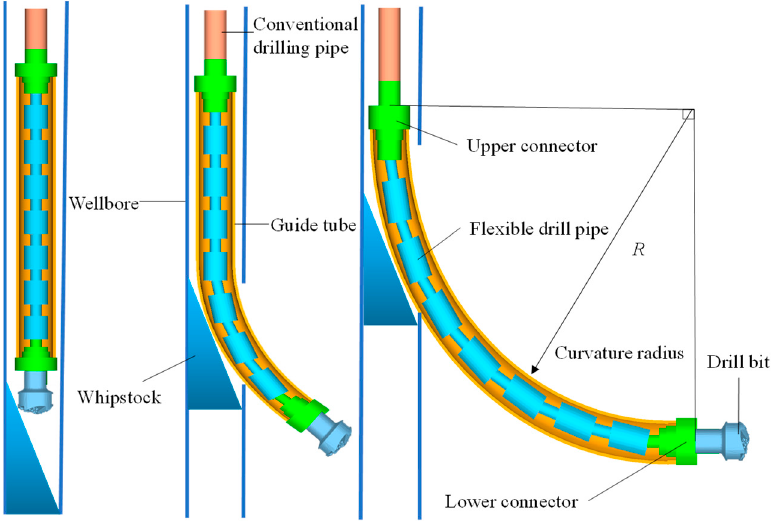
Figure 1. Structure of flexible drill tool.